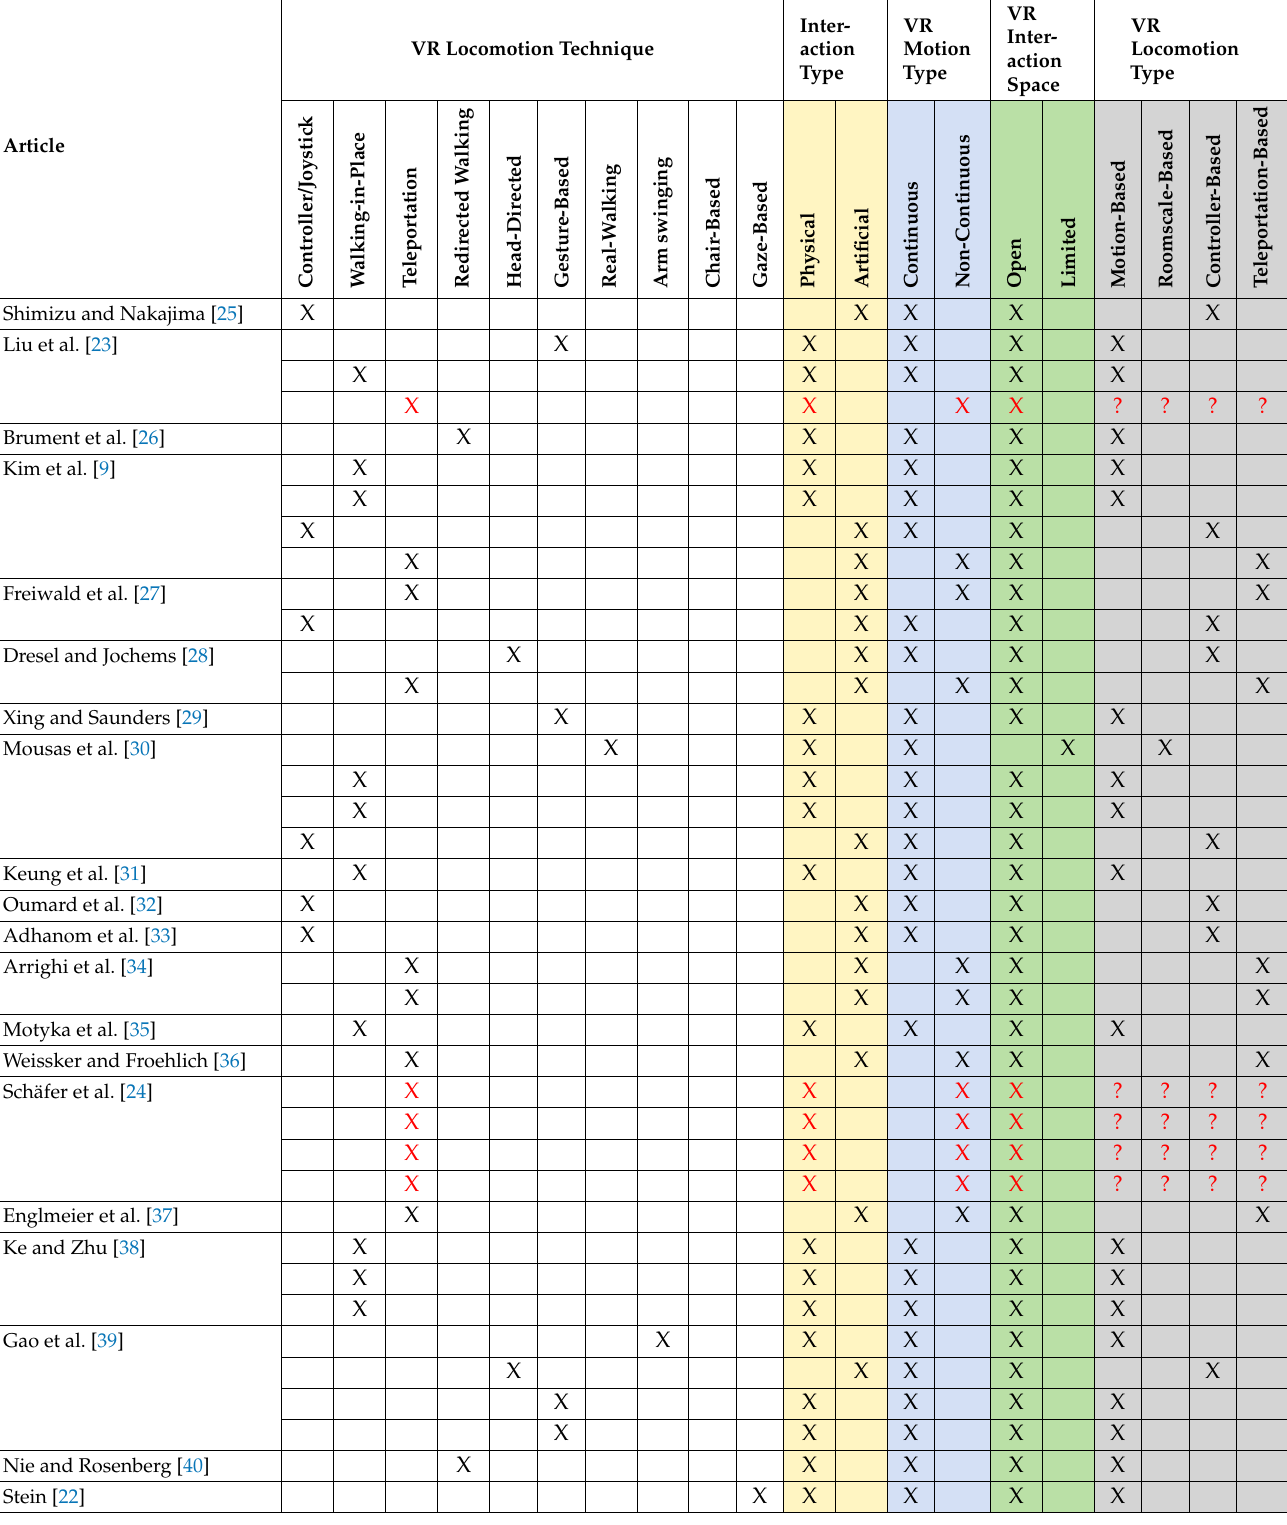
Table 1. The reviewed techniques and their interaction aspects, classified into a concept matrix based on the proposed typology of Boletsis [3]. Techniques that are not covered by the typology are highlighted in